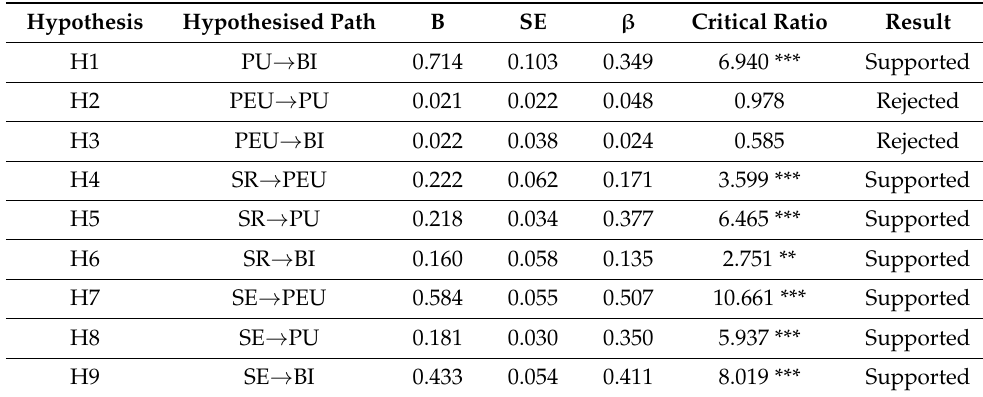
Table 5. The results of structural equation